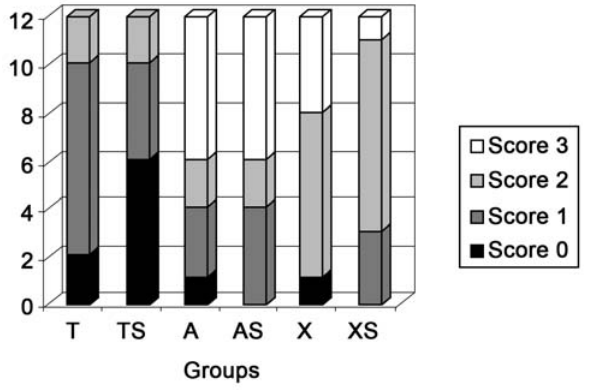
FIGURE 3- Distribution of the adhesive remnant index scores. T= Transbond XT; TS= Transbond with contamination; A= AdheSE; AS= AdheSE with contamination; X= Xeno III; XS= Xeno III with